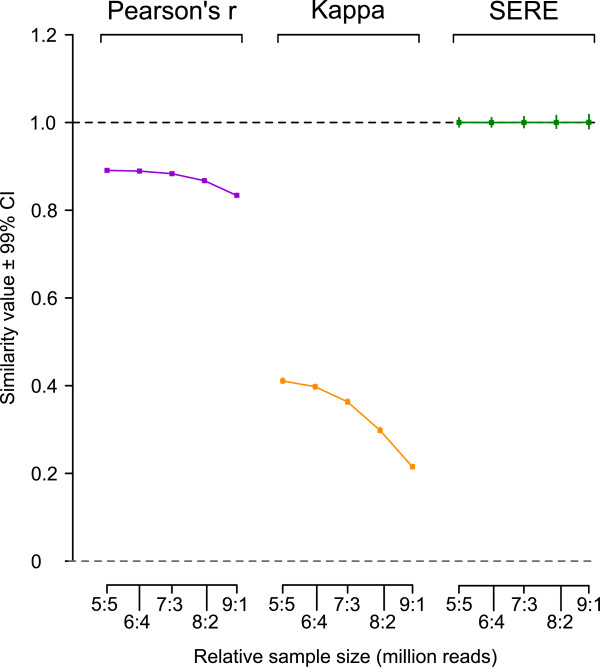
Impact of unequal sample sizes. Pairwise comparisons of perfect in silico replicate RNA-Seq datasets were made similarly to Figure
2, but keeping the total read count for each pair constant while systematically varying the relative size of both datasets, e.g., 1x106 plus 9x106, 3 x106 plus 7 x106, 5 x106 plus 5 x106. Pearson’s r and Kappa fell for unequal sample sizes demonstrating a maximum for equal sample sizes. SERE remained stable at 1.0 while the 99% CI of repeat measures was optimal (smallest) for equal sample sizes.